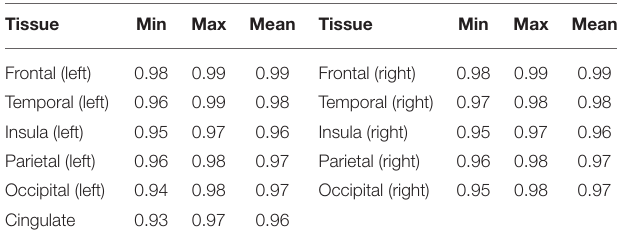
TABLE 3 | Dice Scores obtained on the dHCP test set for the trained cortical parcellation network.